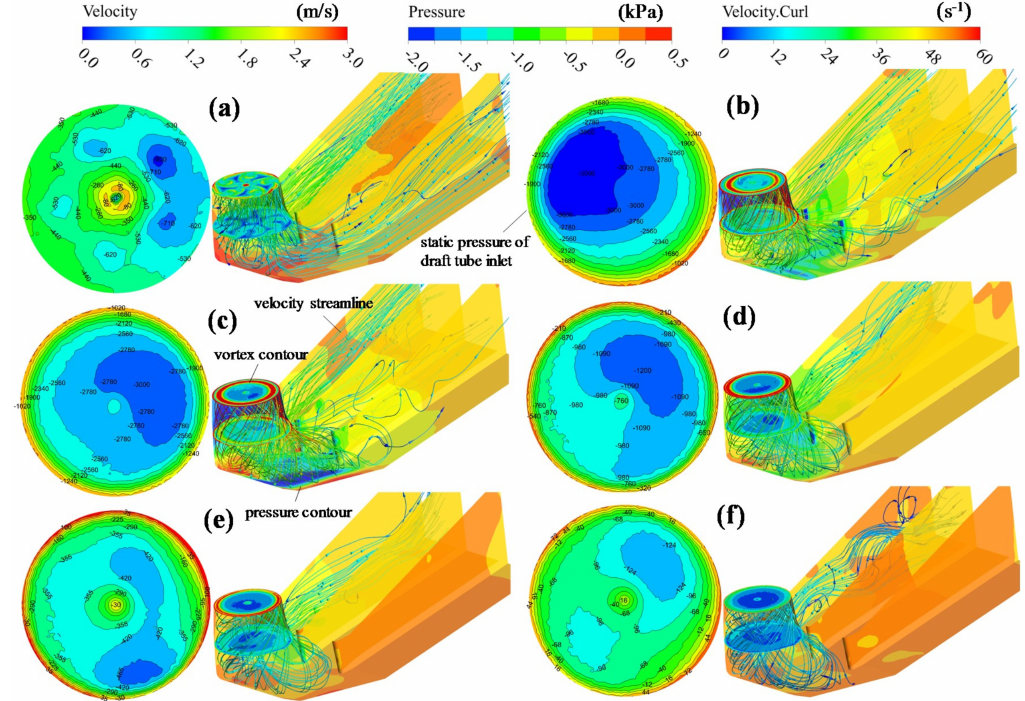
Figure 14. Flow fields in the draft tube at different time: ( a ) t = 0 s, ( b ) t = 1.76 s, ( c ) t = 2.3 s, ( d ) t = 4.8 s, ( e ) t = 6.4 s, and ( f ) t = 9.2